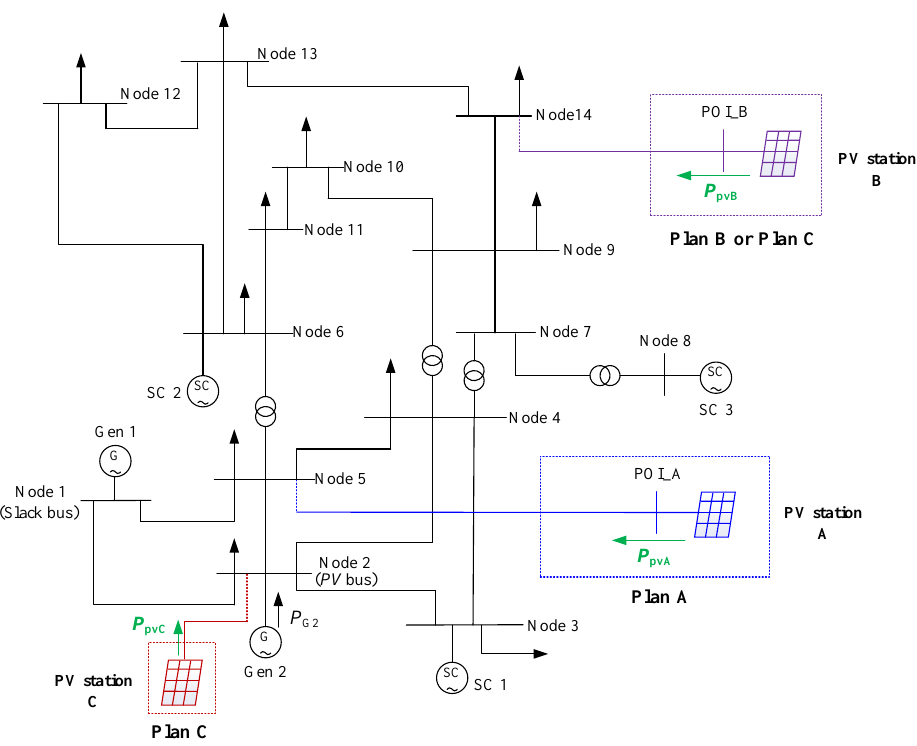
Figure 3. The classic IEEE 14-node system with PV station.